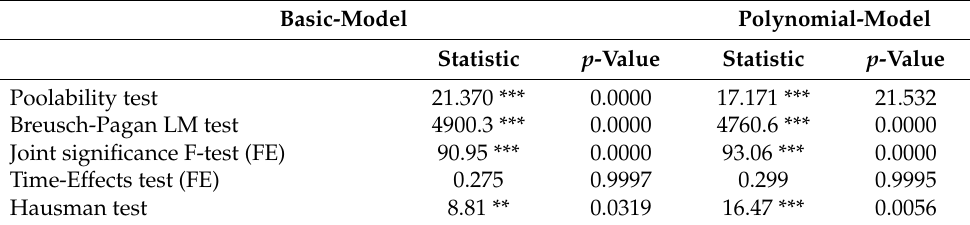
Table 11. Diagnostic tests for static econometric